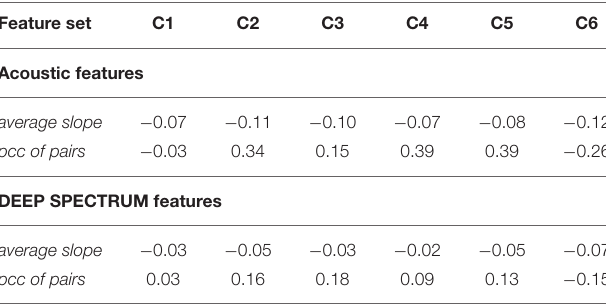
TABLE 3 | Average slope of RMSE sequences of all subjects and the Pearson correlation coefficients of pairs in each culture (C1: Chinese, C2: Hungarian, C3: German, C4: British, C5: Serbian, and C6: